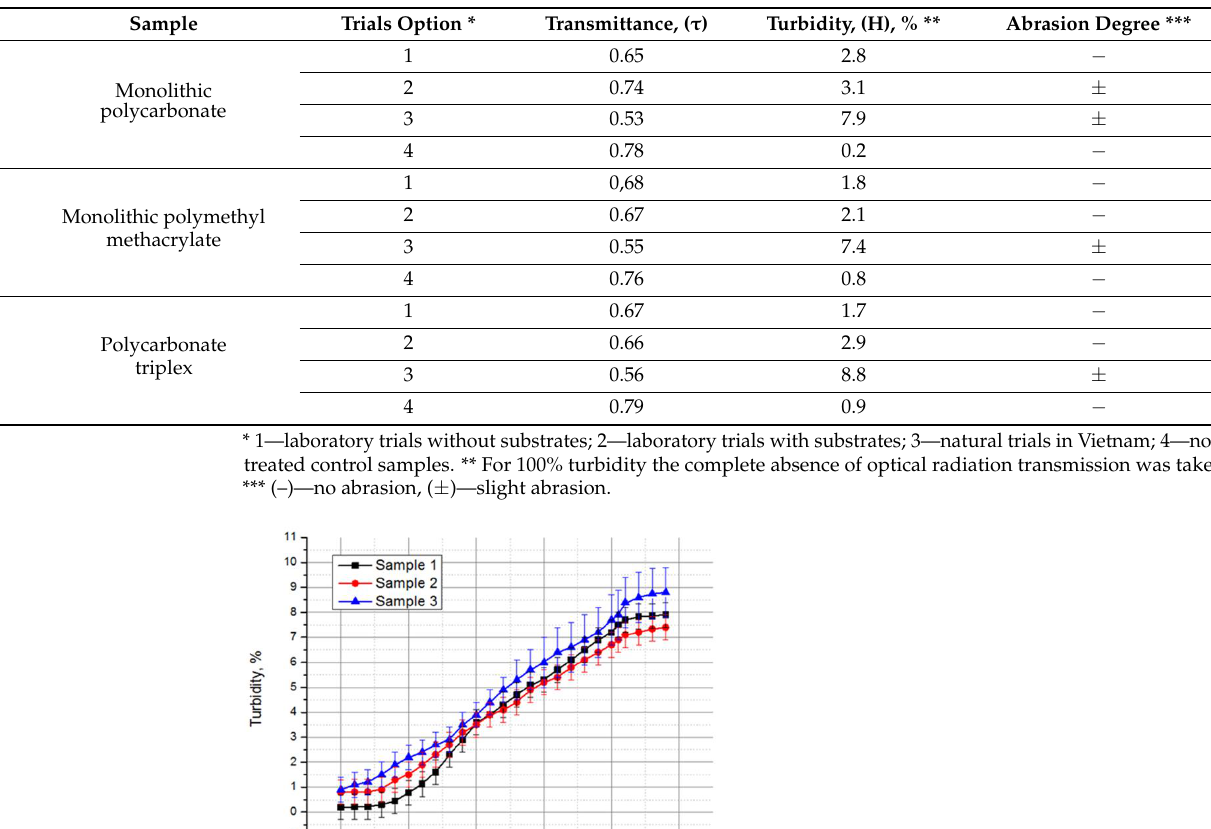
Table 1. Optical–mechanical properties of the polysiloxane-coated samples after laboratory and natural trials.